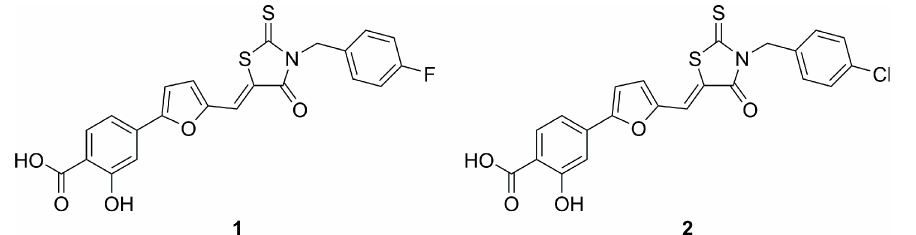
Fig 1. 2D structures of HIV-1 inhibitors previously published.